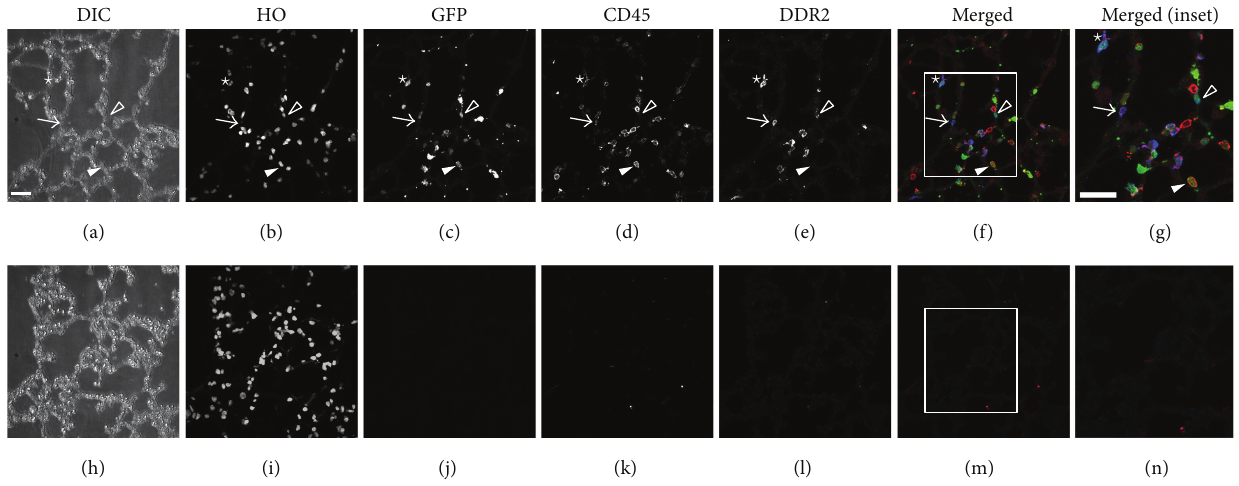
Figure 4: EGFP + CFPs are present in the lungs of nonadherent transplant engrafted mice. Differential interference contrast (DIC), Hoechst nuclear stain (HO), GFP, CD45, and DDR2 antibody stain are shown from a representative lung section from an engrafted animal in Panels (a)–(e), respectively. Panel (f) shows merged image of GFP (green), CD45 (red), and DDR2 (blue) staining. A representative GFP + /CD45 + /DDR2 + cell is indicated by *; a representative GFP + /CD45 + cell is indicated by a solid arrow head; a representative GFP + /DDR2 + cell is indicated by an open arrow head; and a representative CD45 + /DDR2 + cell is indicated by an arrow. Panel (g) shows higher magnification of inset (boxed area) in Panel (f) with * indicating a GFP + /CD45 + /DDR2 + expressing cell. Panels (h)–(n) depict images of secondary only controls. Bar = 25 𝜇 M.